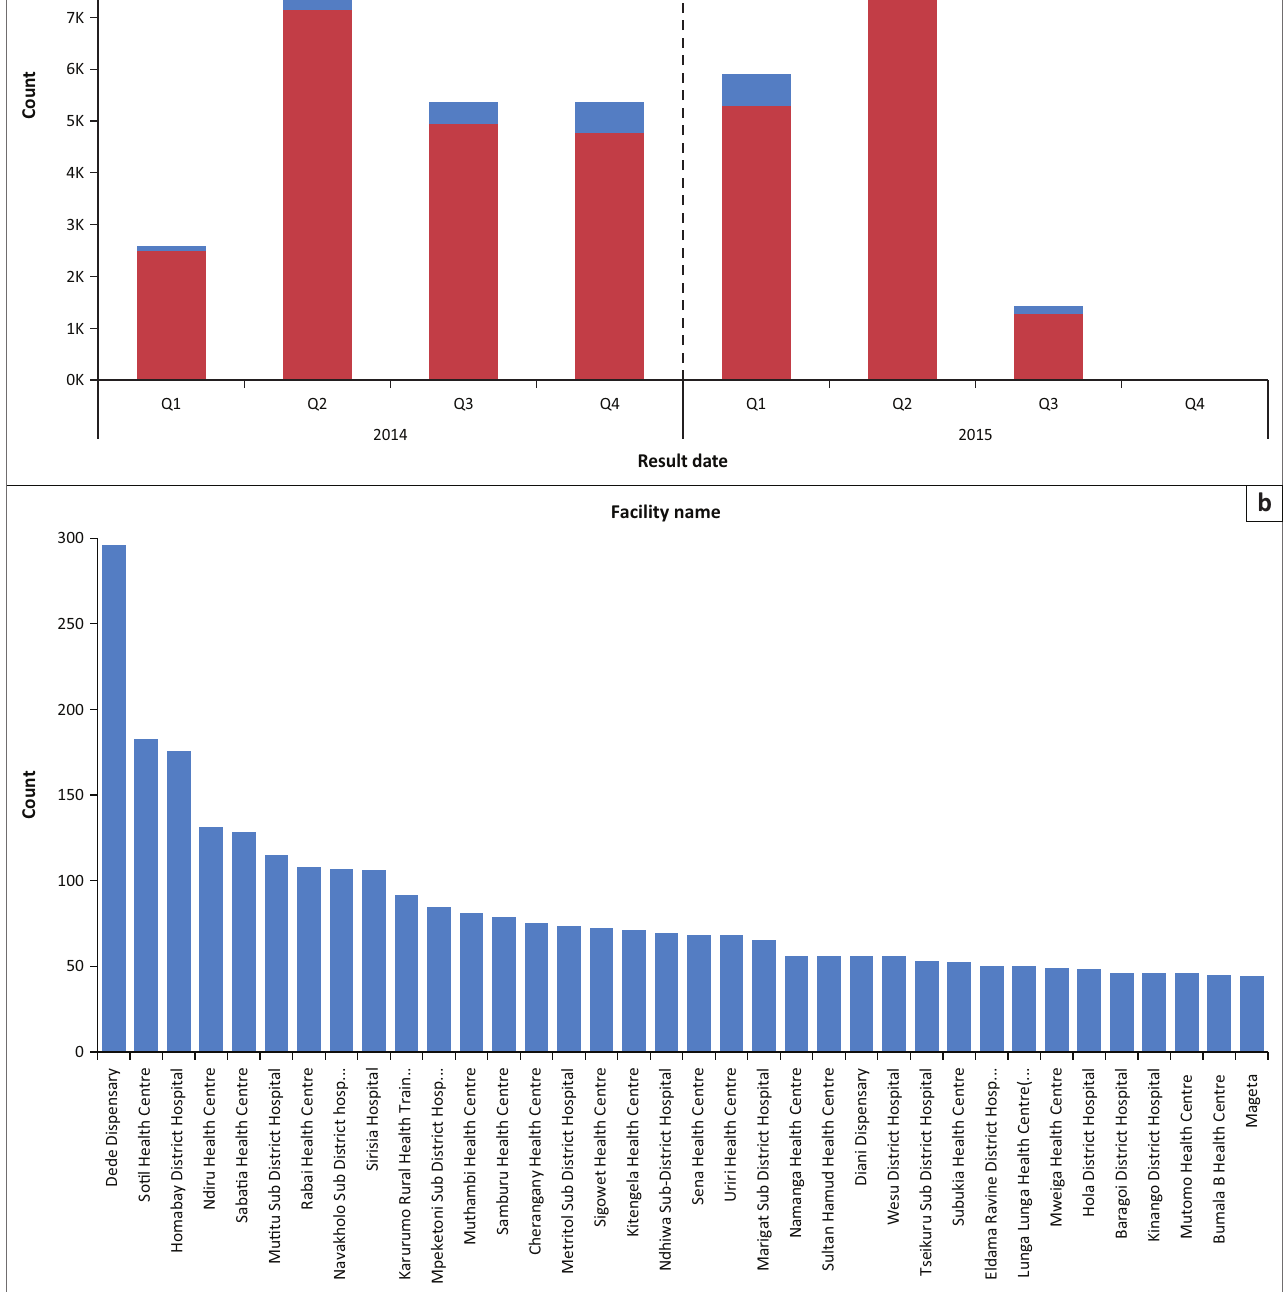
FIGURE 3: (a) CD4 Pima™ POC testing trends 2014–2015 error rates; (b) Drill down to sites with high error rates: top 36 sites in Kenya contributing to 75 % of the total error